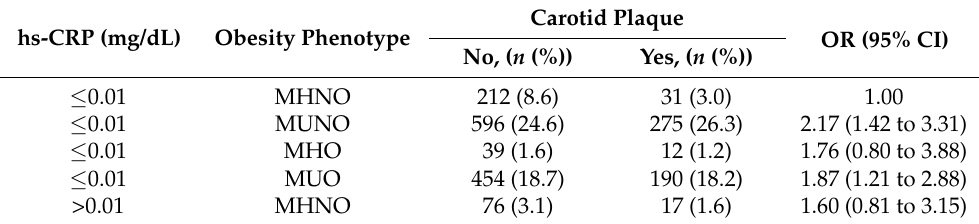
Table 4. Multifactorial logistic regression analyses for carotid plaque according to the obesity pheno- types and